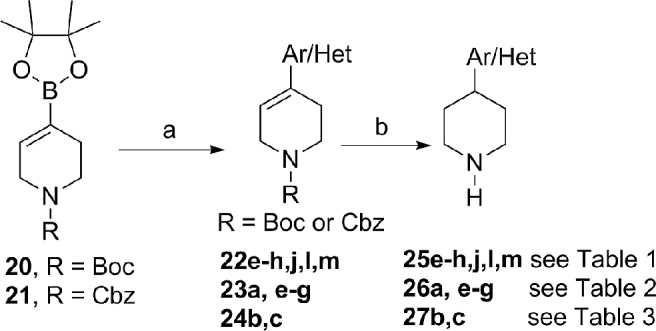
aReagents and conditions: (a) aryl/heteroaryl halide, Pd(dppf)Cl2, DME, 1 M aqueous Na2CO3, microwave, 120 °C, 45 min; (b) (i) Pd(OH)2 on carbon, EtOH, 1 M HCl, H2, room temp 1 h or 10% Pd/C, EtOH, H2, room temp, 2 h, (ii) when R = Boc: 4 M HCl in dioxane, room temp, 2 h or when R = Cbz: AcOH, 10% Pd/C, H2, room temp, 4–6 h.